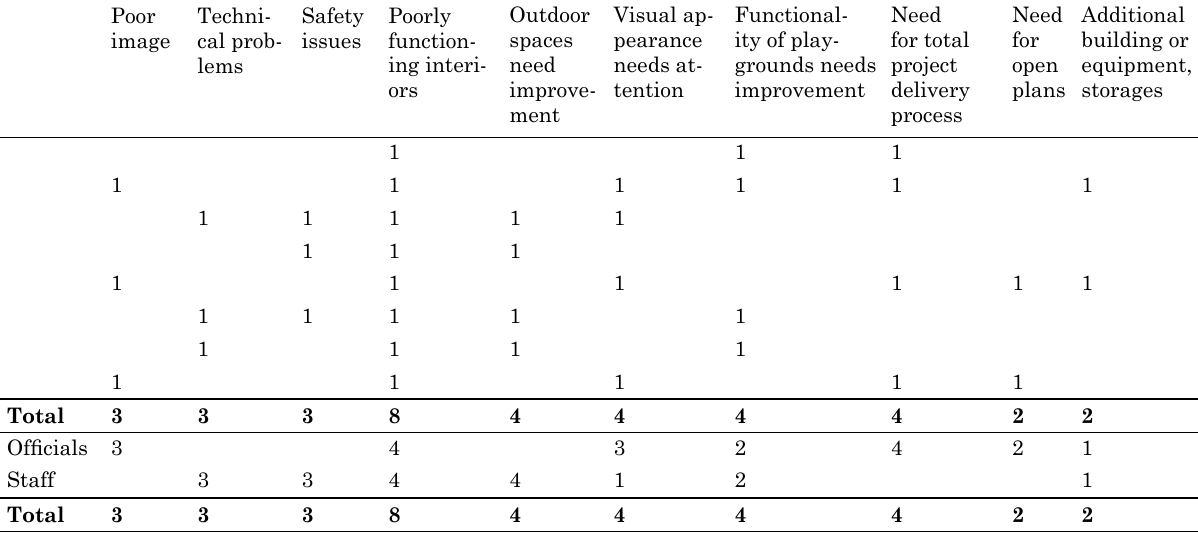
Table 2. Categories of stakeholder